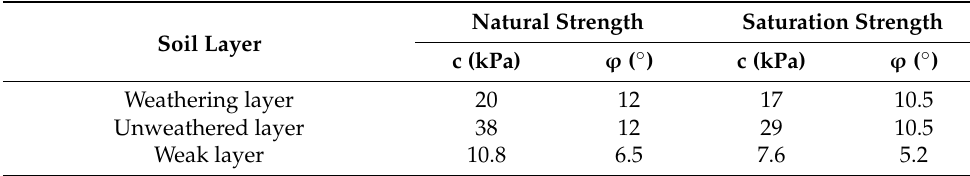
Table 3. Strength